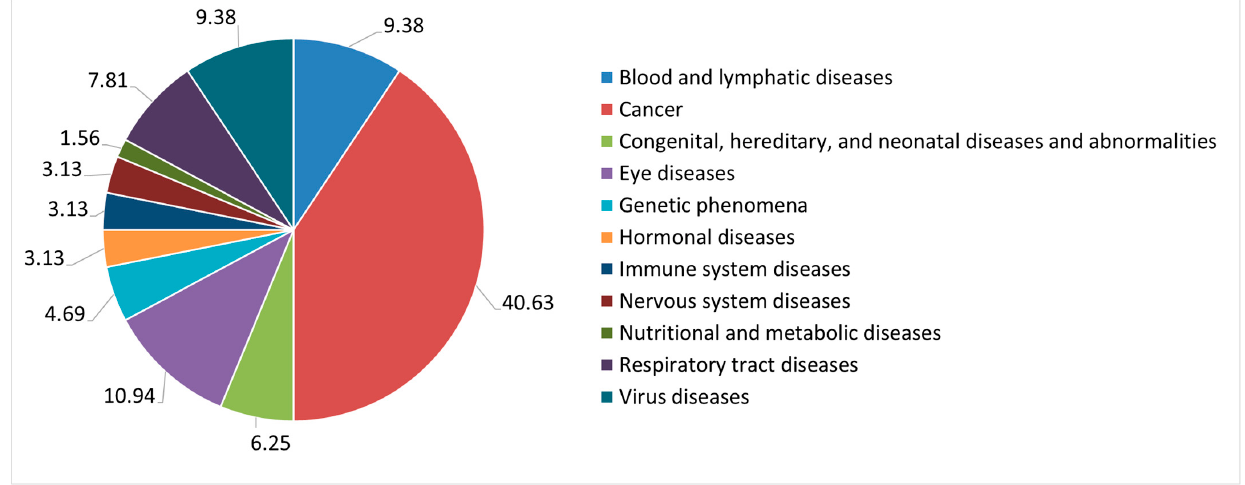
Figure 4. Distribution of therapeutic areas of CTs, including a nanomedicine tested as an IMP, assessed and authorized from 2018 to 2020.